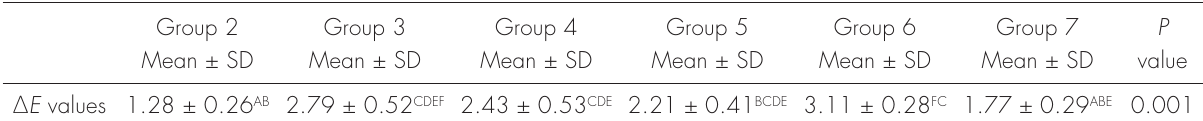
Table IV. Color change results for 24 hr immersion.